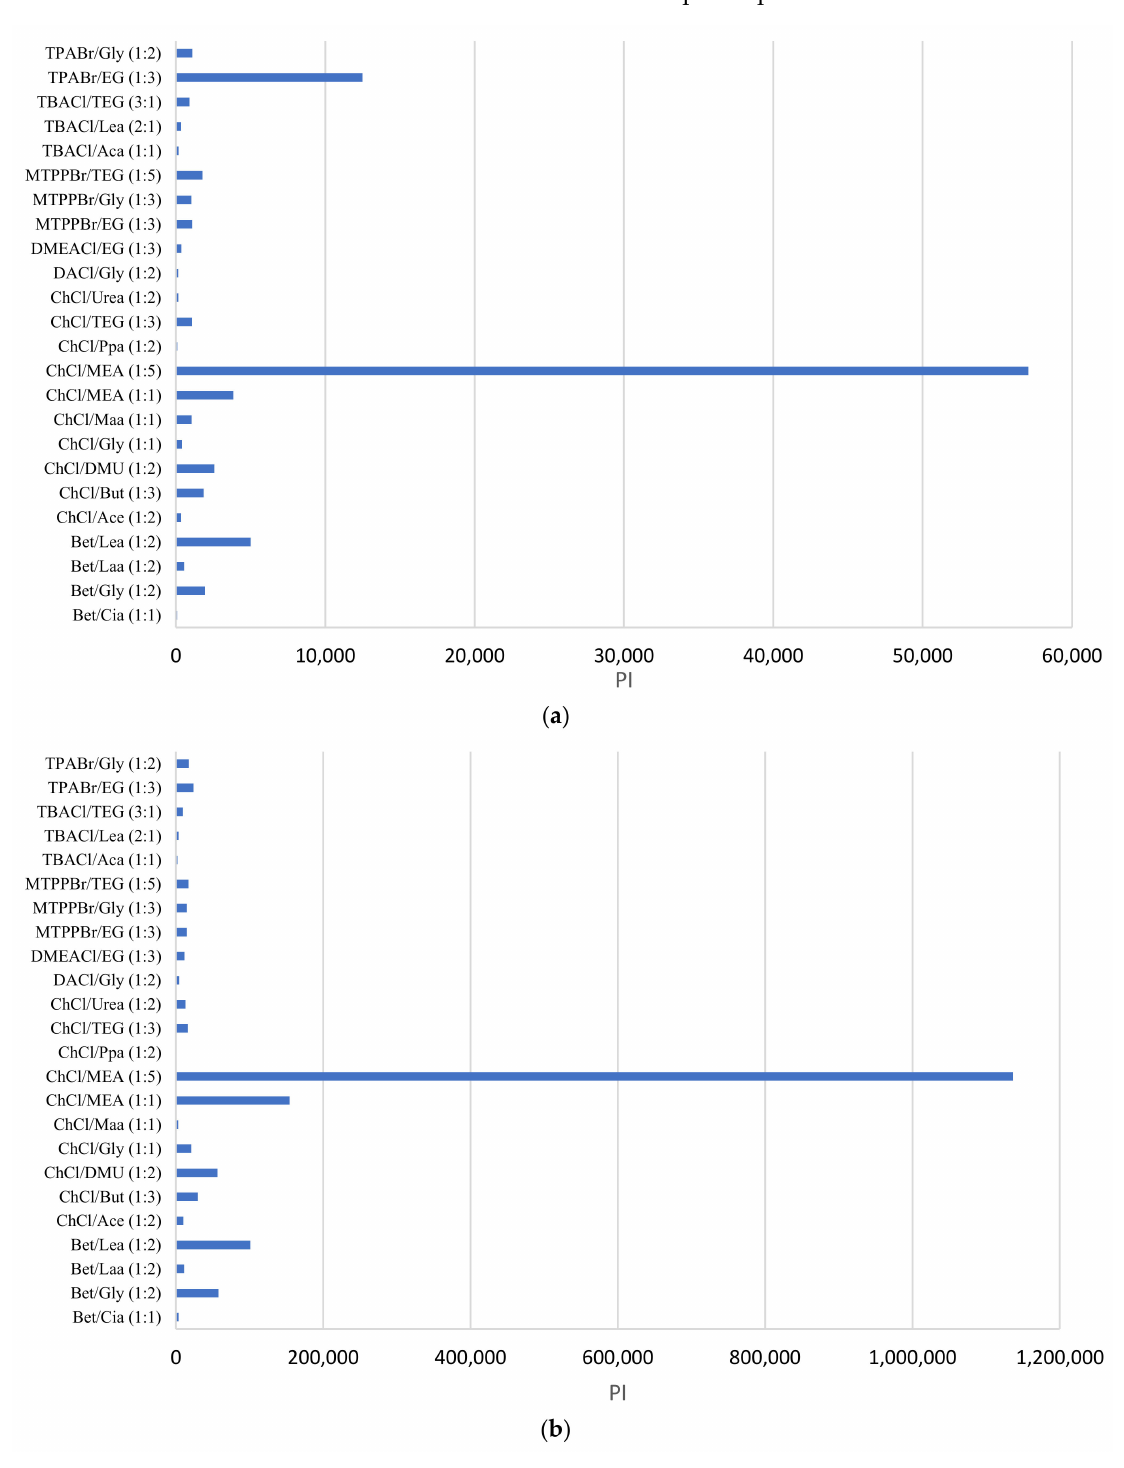
Figure 4. Performance index of DESs for the separation of ( a ) phenol in toluene, and ( b ) phenol in